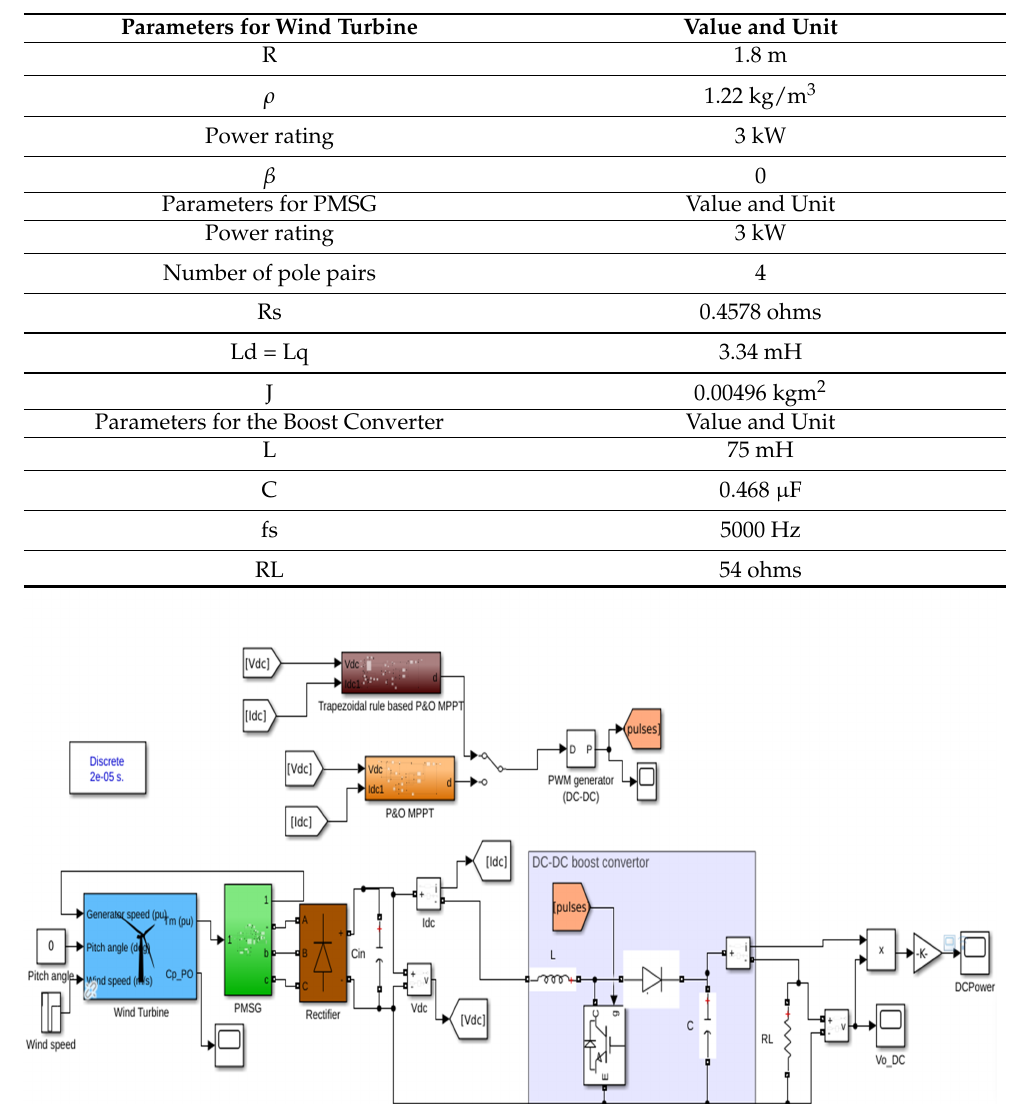
Table 2. Parameters used for simulation.